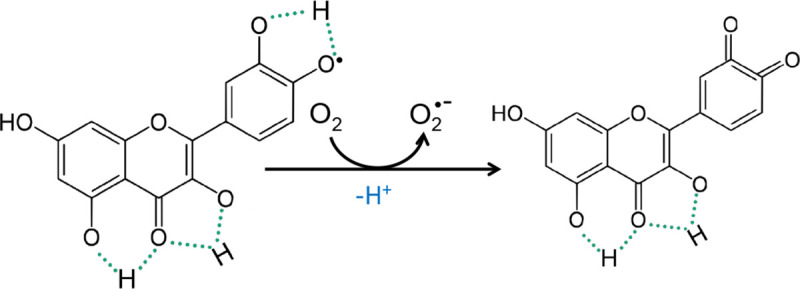
The mechanism of pro-oxidative activity [36].